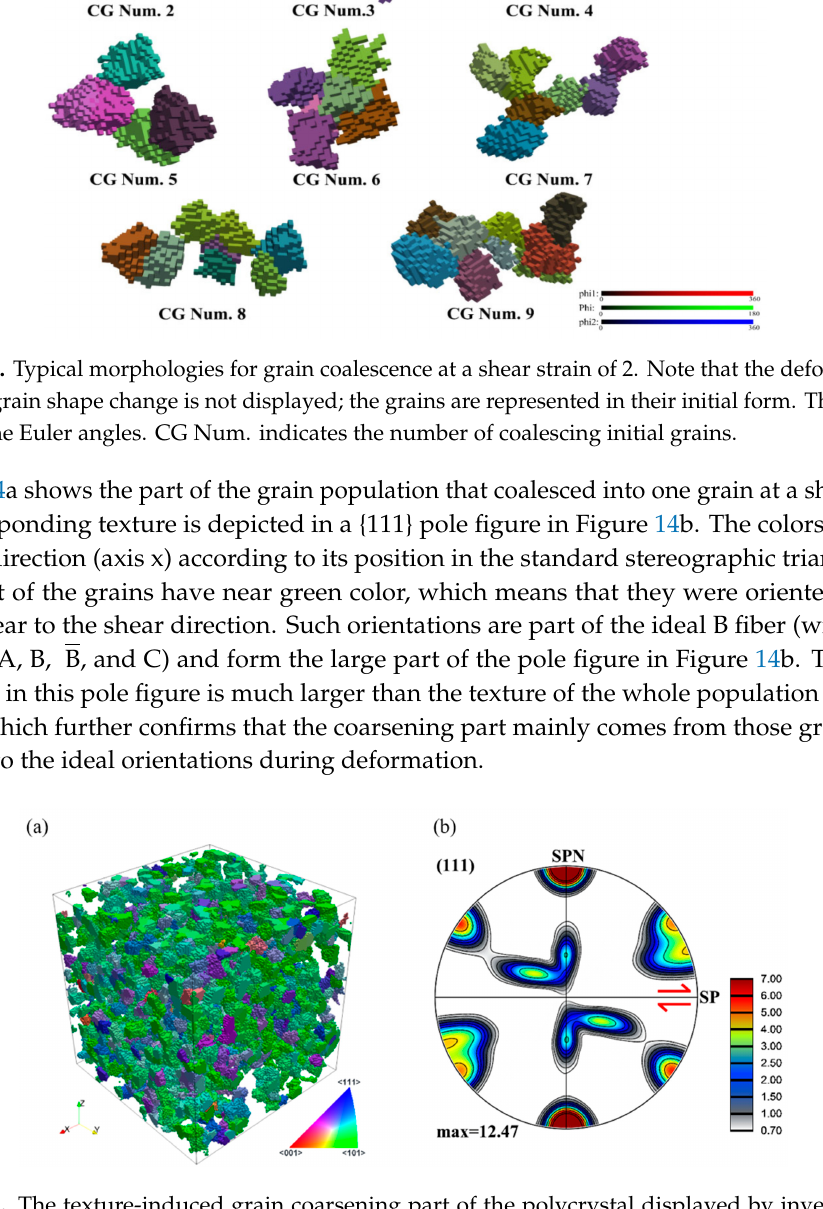
Figure 14. The texture-induced grain coarsening part of the polycrystal displayed by inverse pole figure (IPF) 3D mapping in the real space ( a ) and its corresponding texture at a shear strain of 2 ( b ). The starting texture was